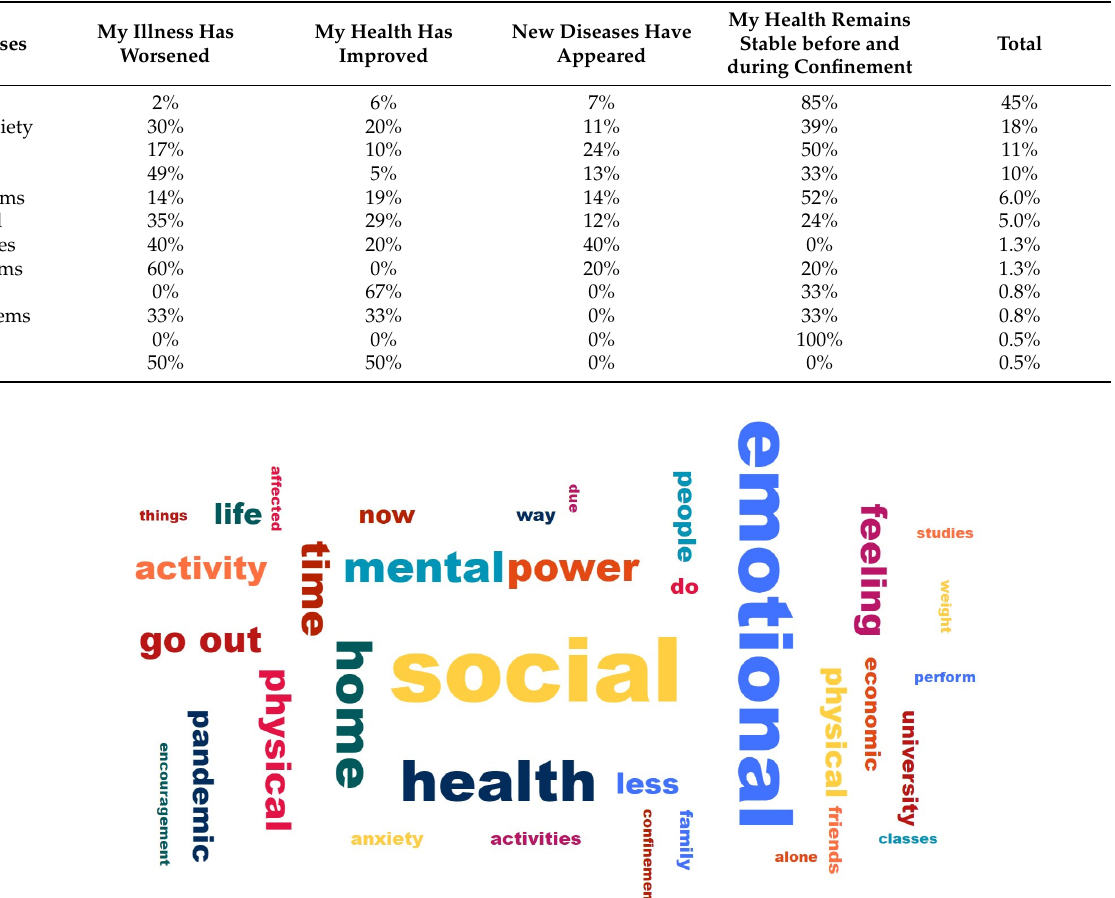
Table 7. Perception of pre-existing diseases during confinement.